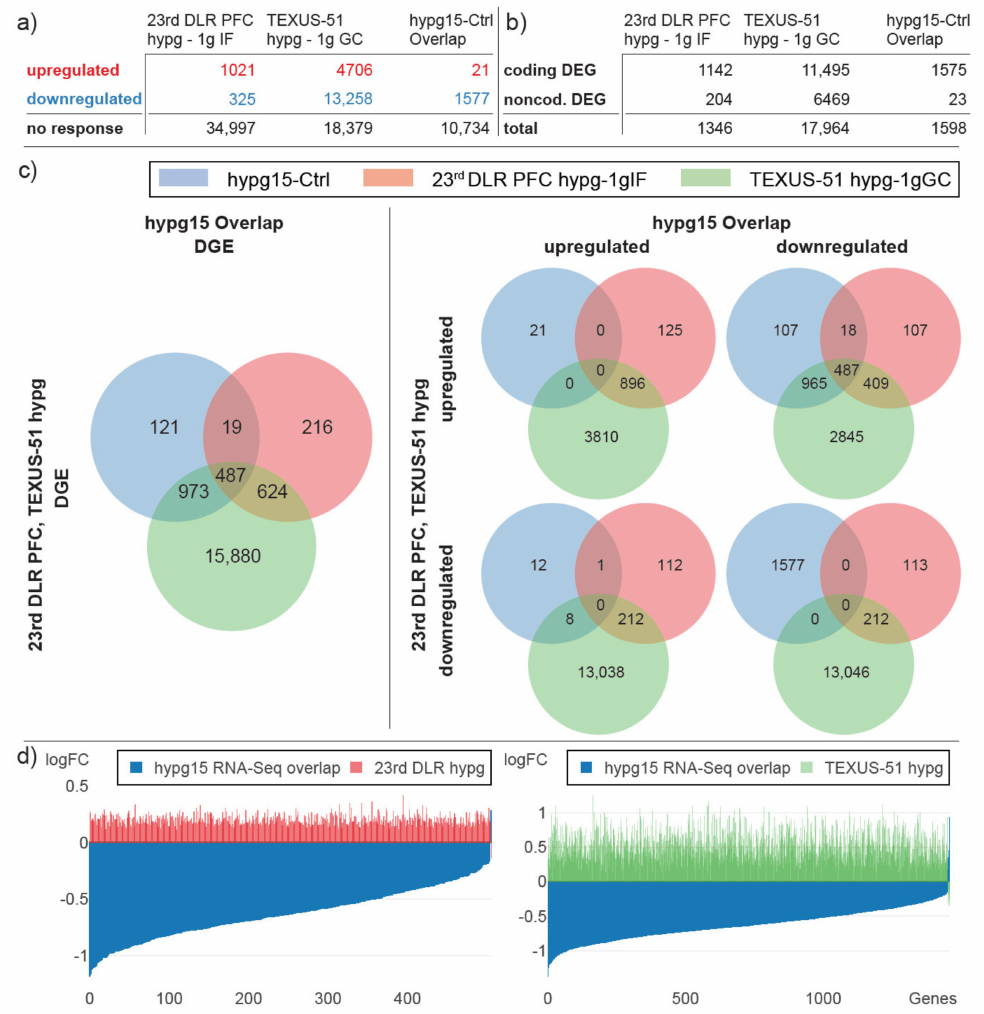
Figure 6. Cross-comparison of transcriptional behavior with short hypergravity microarray tran- scriptomics data sets, 23rd DLR PFC 20 s 1.8 × g hypergravity (hypg) vs. 1 × g in flight control (1gIF) and TEXUS-51 75 s ~9 × g baseline hypergravity (hypg) vs. 1 × g ground control (1gGC), parallel to Figure 5. 15 min hypergravity, only genes that are differentially expressed in the microarray and RNA-Seq data set. ( a ) Significantly up- and downregulated genes and non-responsive genes for the two previous data sets and the hypg15 data set from this study, overlap between microarray and RNA-Seq data. ( b ) Significantly differential expressed genes, aggregated by protein-coding genes and noncoding genes for all three data sets. ( c ) Overlap between differentially expressed genes for all three data sets. Left: all significantly differentially expressed genes. Right: differentially expressed genes, split by upregulated and downregulated genes for the hypg15 overlap data set (horizontal axis) and by upregulated and downregulated genes for both external data sets (vertical axis). ( d ) Corresponding fold changes of genes that are differentially expressed both in hypg15 and 23rd DLR PFC hypg (left), resp. TEXUS-51 hypg (right). For each gene, two different fold changes are displayed by two differentially colored bars at the same location on the horizontal